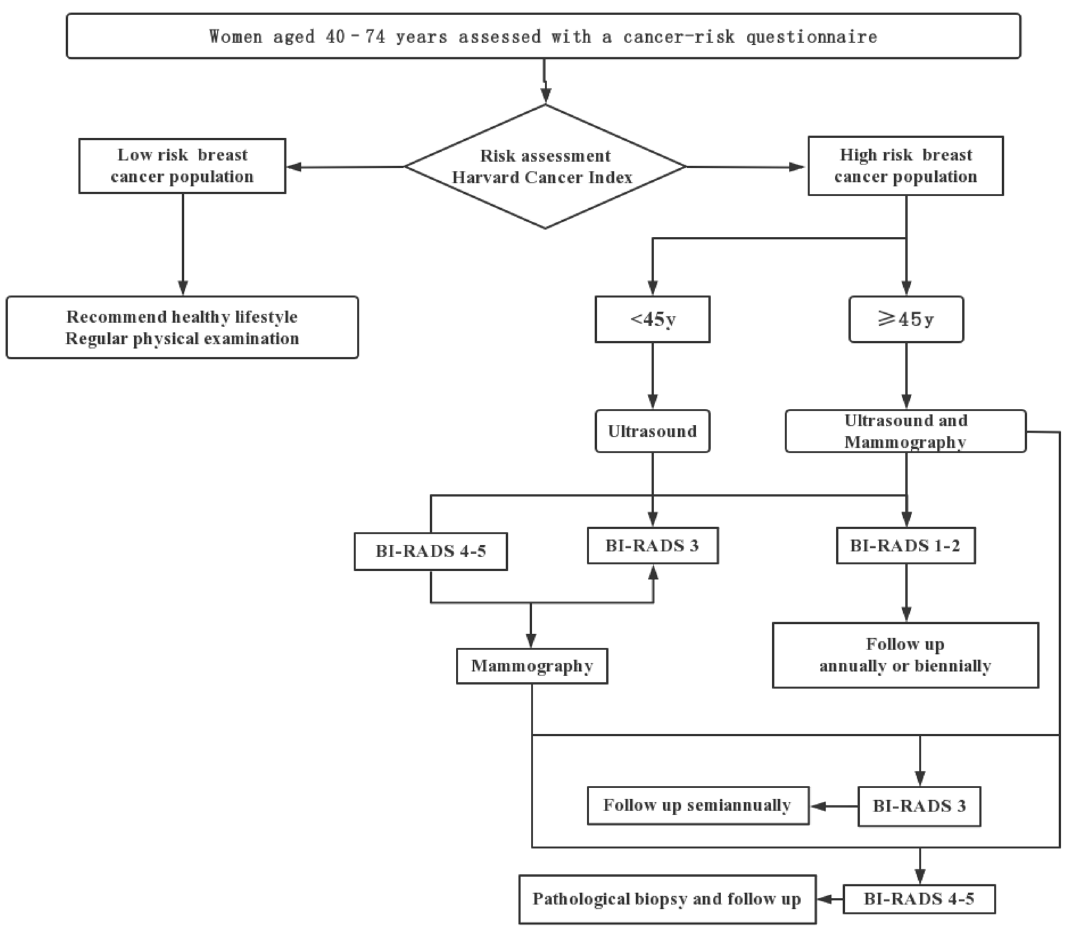
Figure 1. Screening process for breast cancer in Urban Hebei Province.